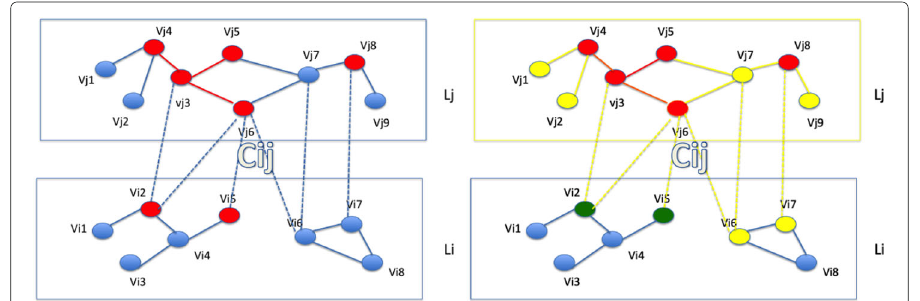
Fig. 7 Reachability from layer j to layer i: red nodes are private ones, yellow and orange nodes are egocentrics ones computed from layer j, green nodes are the egocentric ones that belong to the the private network of the layer i, precisionR(j,i)=0.5 and recallR(j,i)=1: this means that 50% of reachable nodes from layer j are private ones but all private nodes of the layer i are reachable from layer